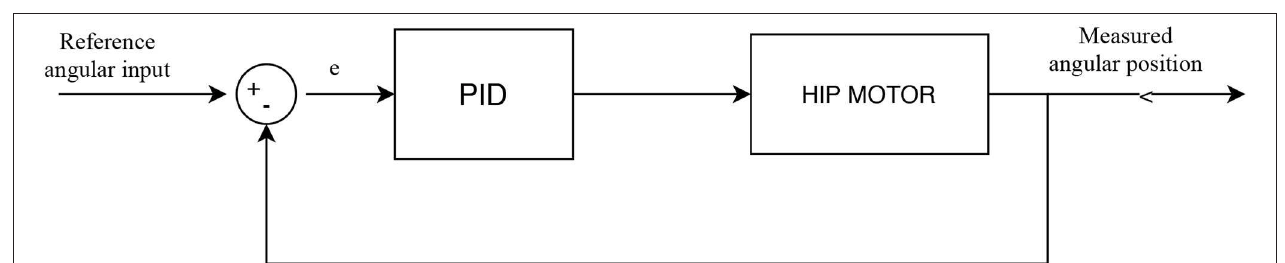
FIGURE 6 | Angular input of hip motors.